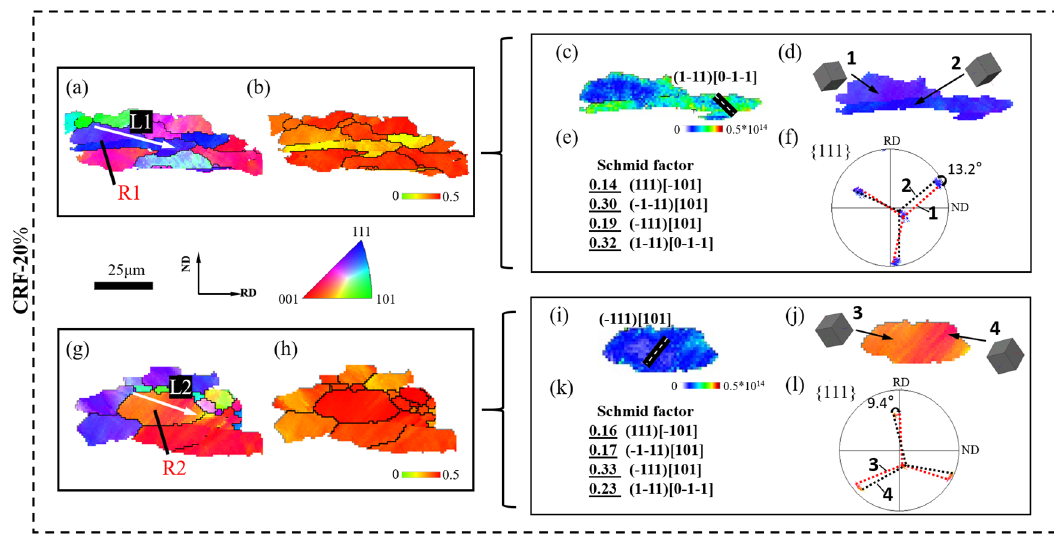
Figure 9. EBSD analysis of local area under CRF-20% conditions: ( a ) IPF map of large SF grains, ( b ) SF map of large SF grains, ( c ) GND map of large SF grains, ( d ) grain orientation of large SF grains, ( e ) SF value of large SF grains, and ( f ) PFs of large SF grains; ( g ) IPF map of small SF grains, ( h ) SF map of small SF grains, ( i ) GND map of small SF grains, ( j ) grain orientation of small SF grains, ( k ) SF value of small SF grains, and ( l ) PF of small SF grains.